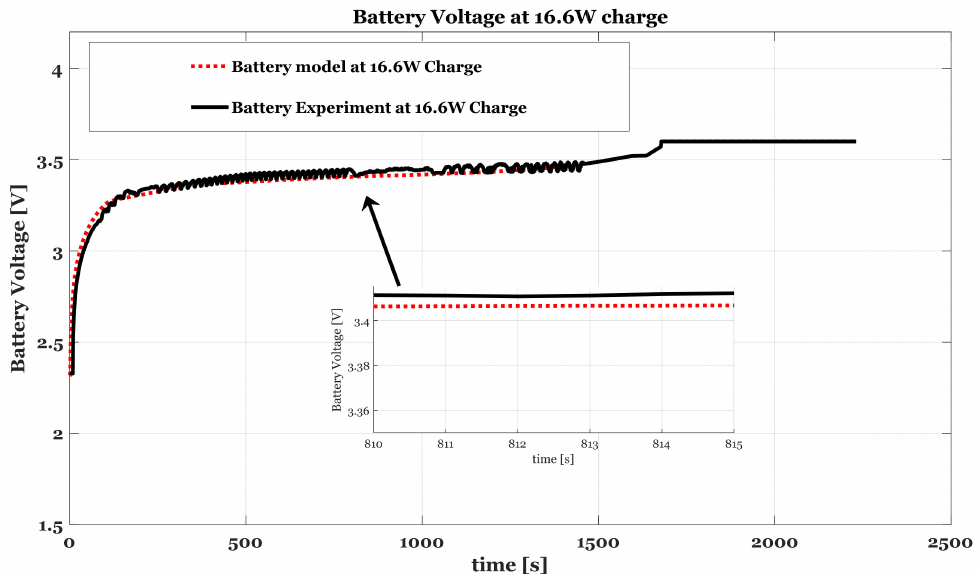
Figure 9. Battery model versus experimental results: Battery charge voltage at 16.6 W (black– experimental, and red–simulation).